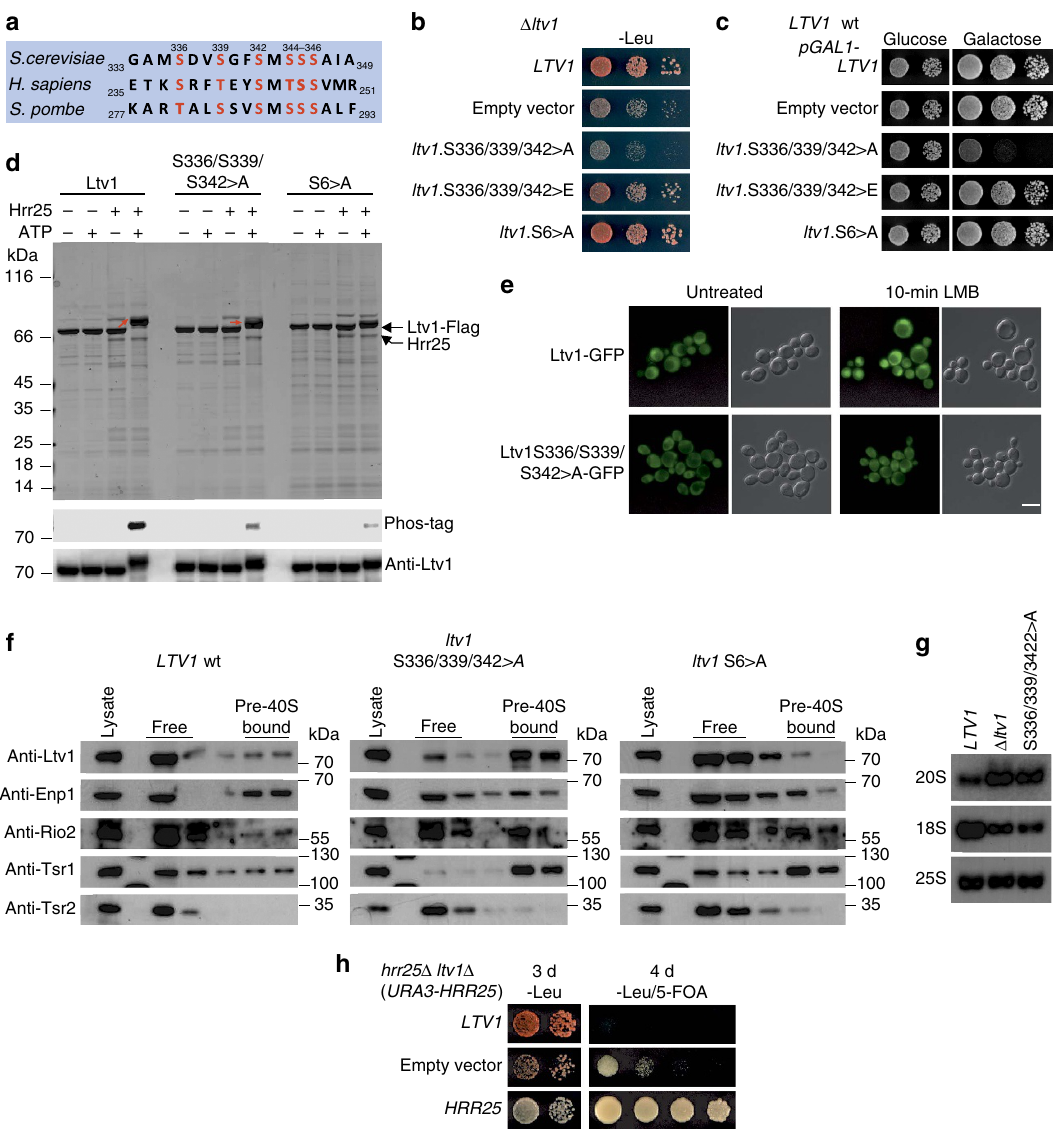
Figure 4 | Cytoplasmic Ltv1 release is triggered by phosphorylation of serines 336, 339 and 342, and is essential for cell growth. ( a ) Sequence alignment reveals a conserved serine/threonine-rich motif in Ltv1 as putative target for phosphorylation by Hrr25/CK1 d / e . ( b ) Growth phenotypes of